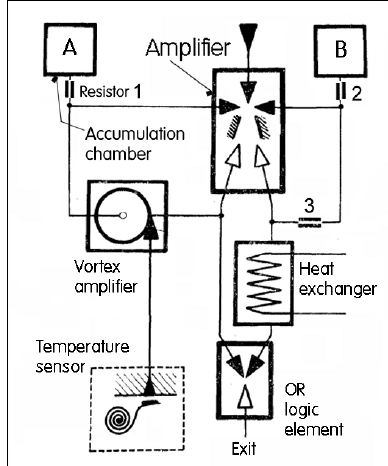
Fig. 12. Schematic representation of pulse-width modulation of heating the air in the terminal unit - with feedback loop asymmetry [6] controlled by vortex